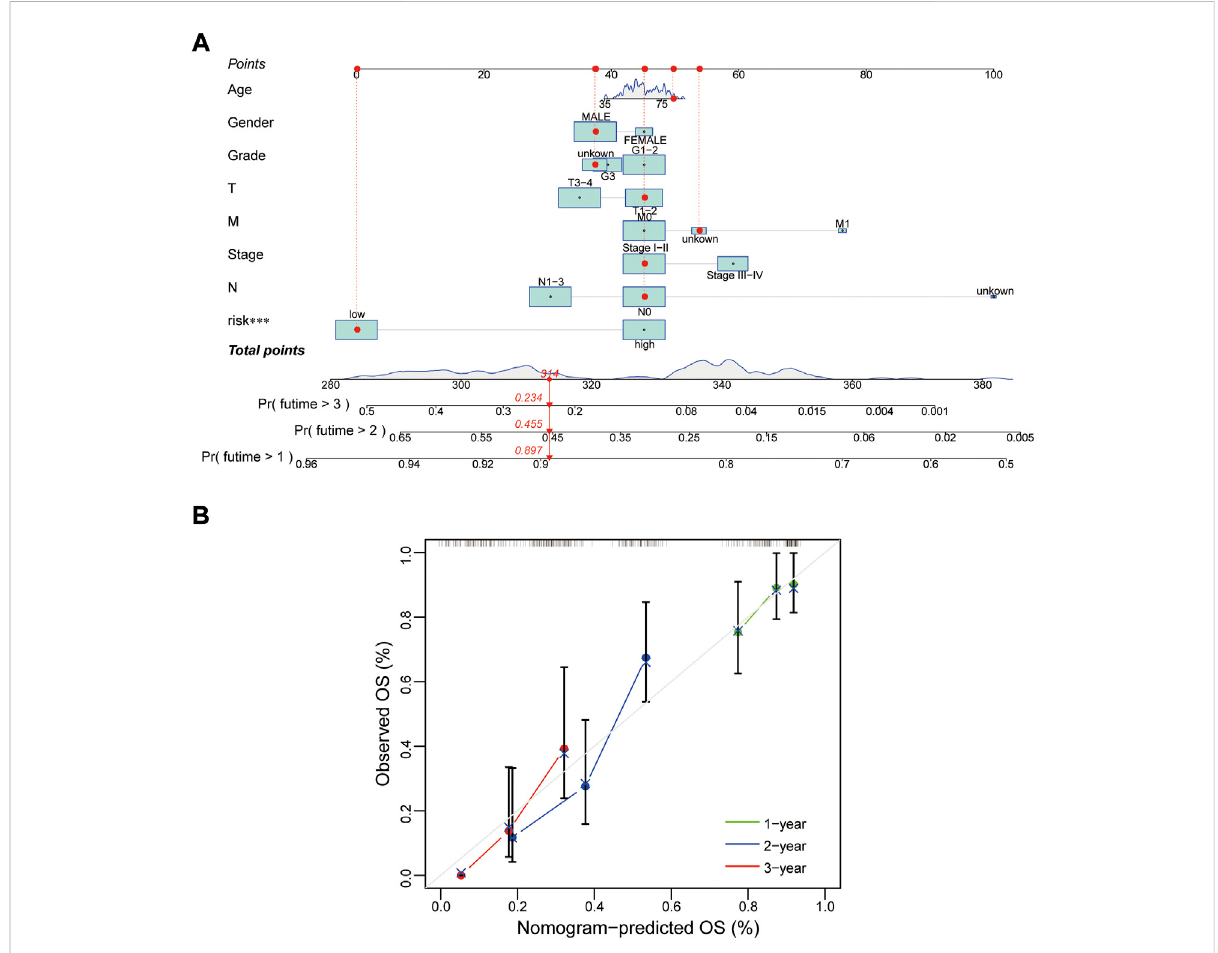
FIGURE 6 Construction of a nomogram. (A,B) Nomogram and calibration plot for predicting 1-, 2-, 3-year survival rate of EC patients. OS, overall survival.